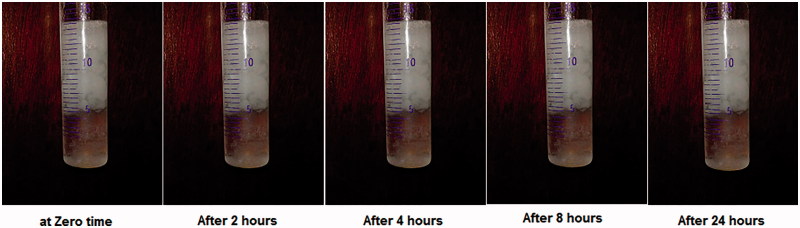
Light photos showing floating behavior of optimized GBP raft formula at different time intervals in 0.1 N HCl.